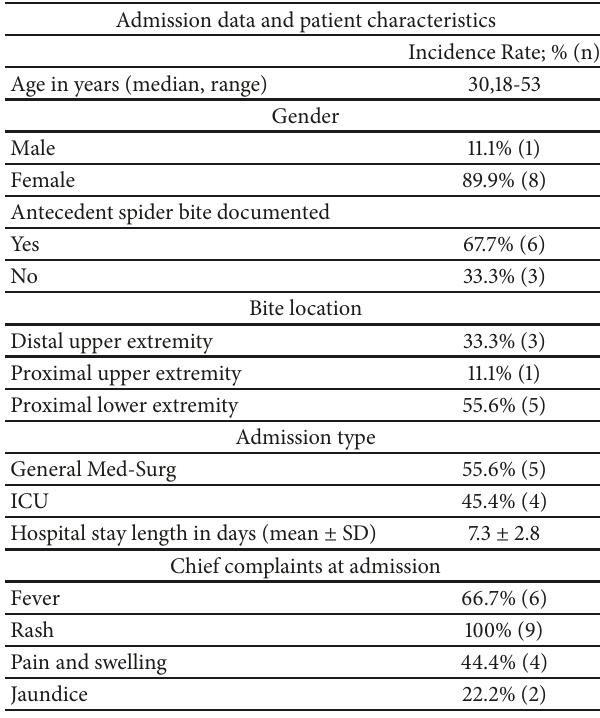
Table 1: Admission data and patient characteristics.